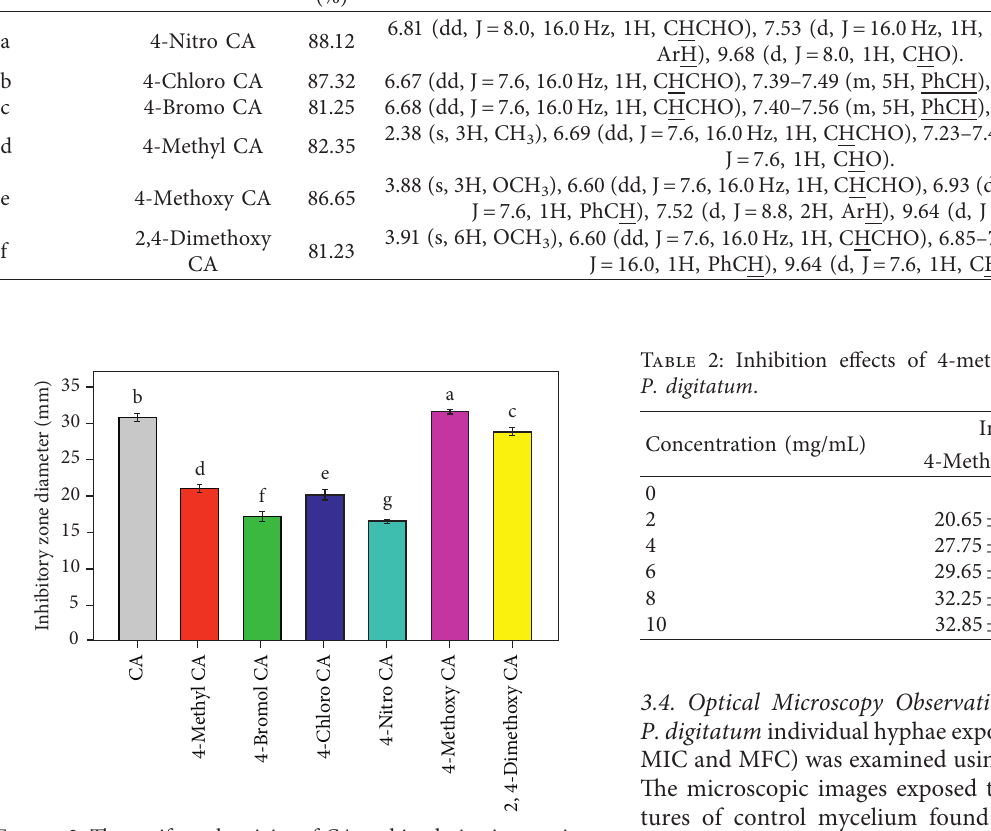
Figure 2: The antifungal activity of CA and its derivatives against P. digitatum (each compound concentration was 8 mg/mL).